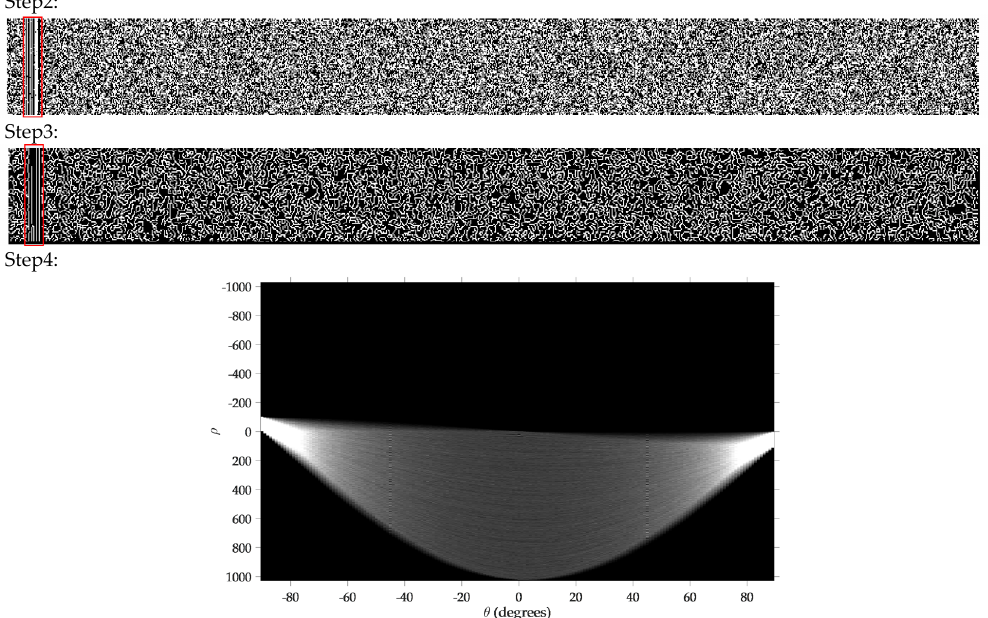
Figure 5. Running results of Step2–Step4. Result of Step2 is the binary image of image matrix C and the result of Step3 is the binary image after edge extraction; the result of Step4 is the Hough space.